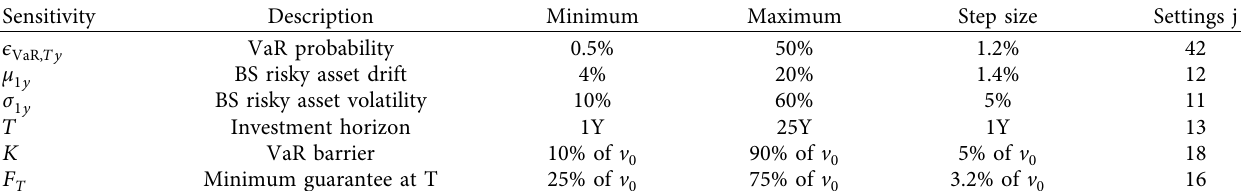
Table 1: Sensitivities for comparative